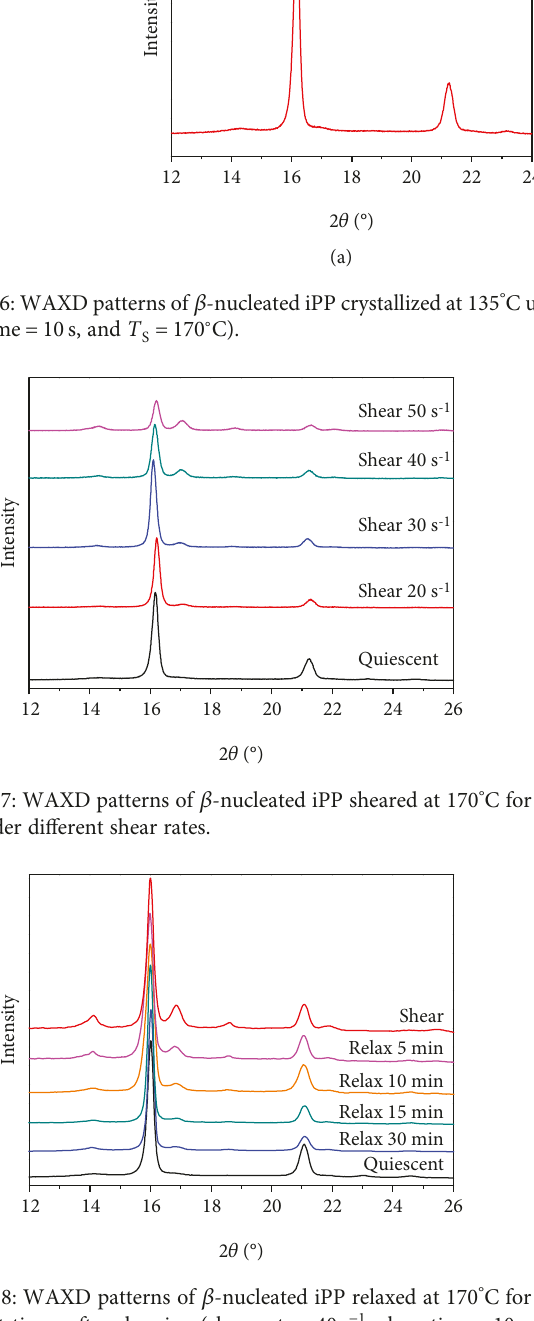
Figure 9: Relative β -phase content as a function of relative shear e ffi ciency for β -nucleated